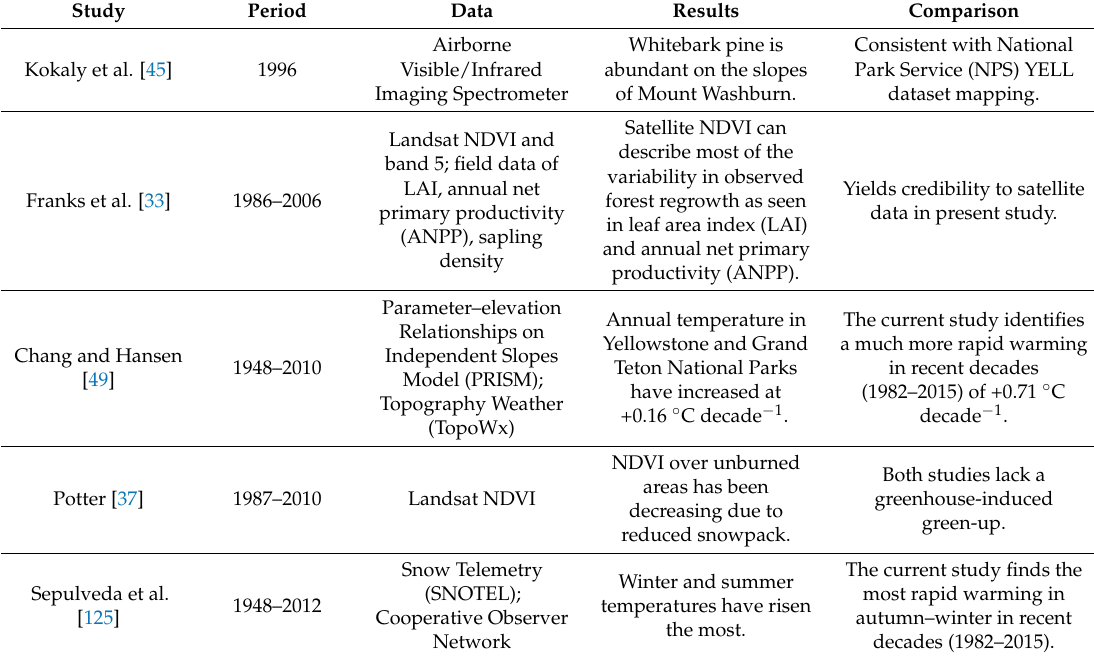
Table 1. Summary of nine papers on variability and change in Yellowstone’s vegetation and climate, including the time period, applied datasets, key results, and comparison of results with the current